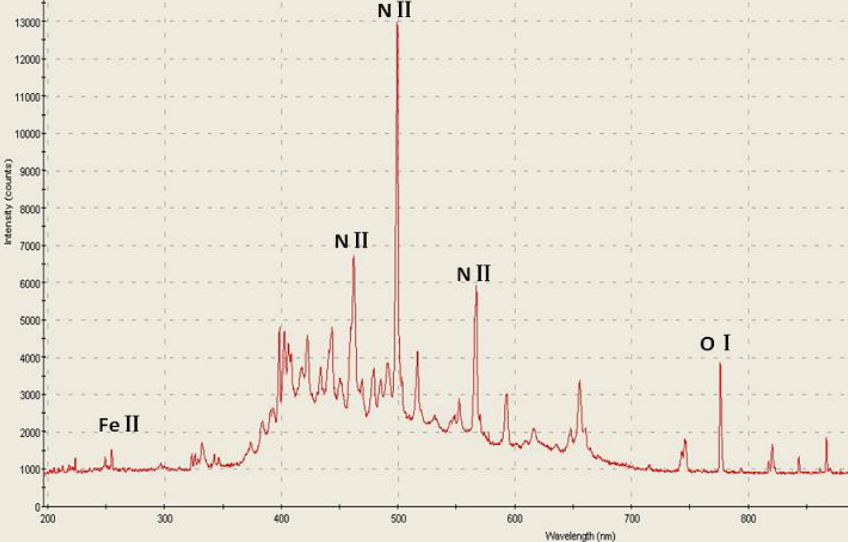
Figure 4. The spark discharge emission spectrum at an electrode distance of 14 mm.